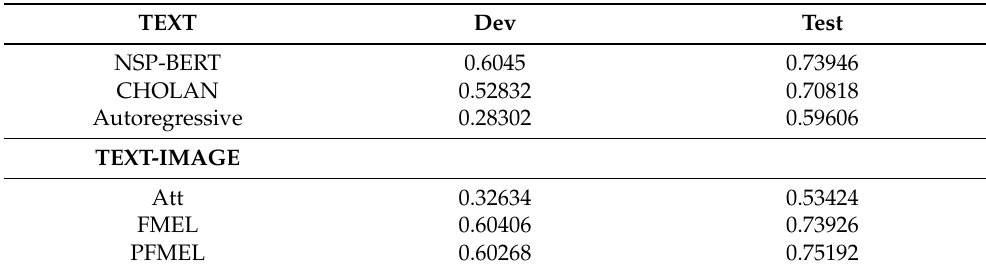
Table 4. Results of different approaches. When our model is not pre-trained and uses only textual information, its structure is the same as NSP-BERT.